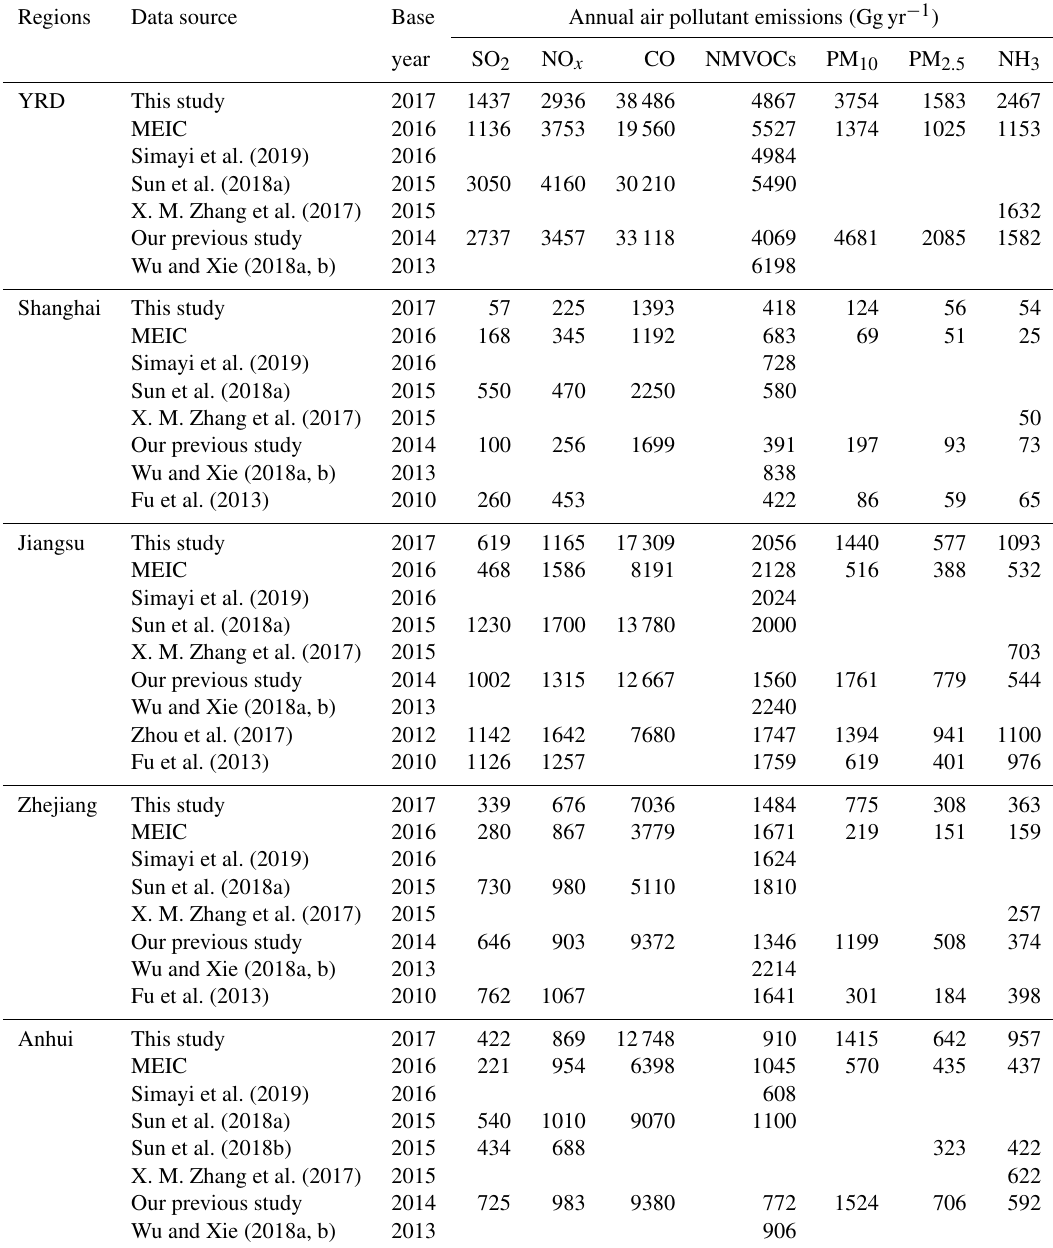
Table 2. Air pollutant emissions in the YRD region and their comparison with other studies.